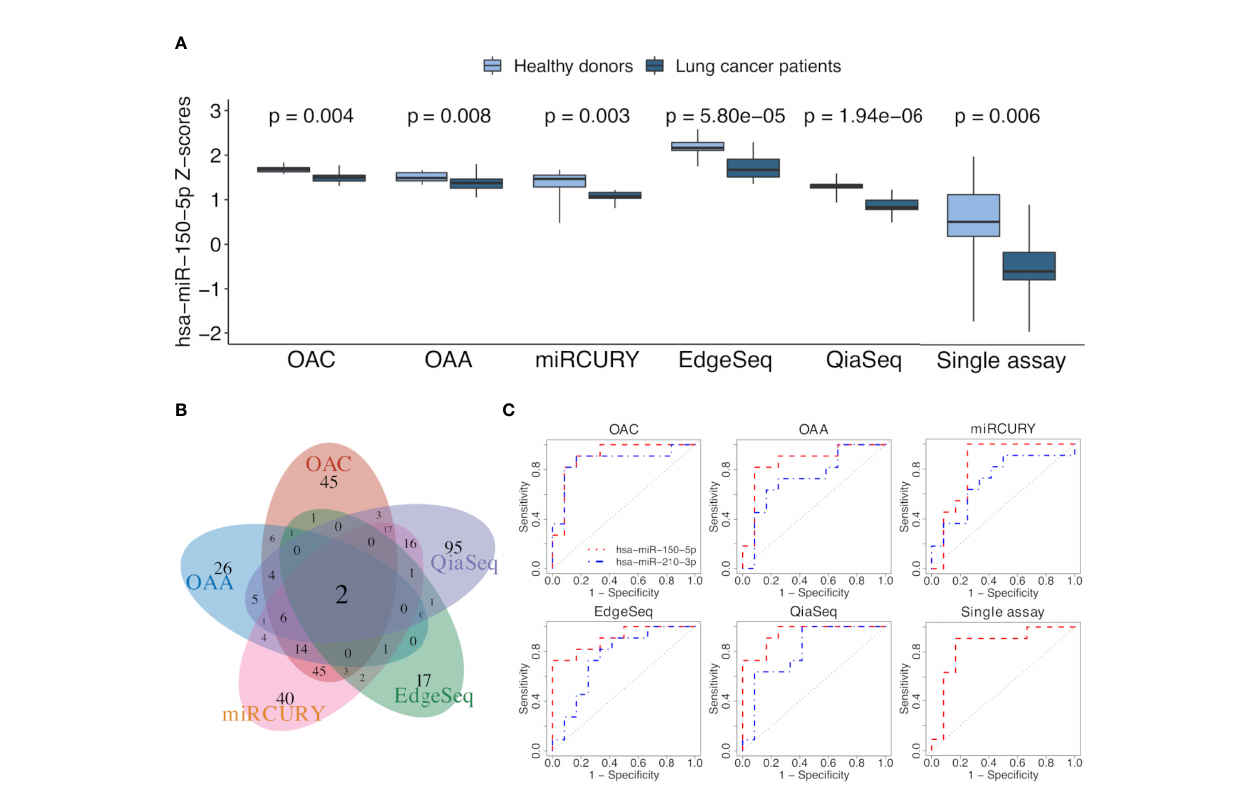
FIGURE 5 | ct-miR differential expression and validation. (A) Boxplots reporting the differences in the expression values of miR-150-5p between non-small cell lung cancer (NSCLC) patients and healthy donors in all platforms. Single-assay validation test of miR-150-5p after normalization to the reference miR-93-5p is reported. All p -values were obtained using limma, except for the single assay where unpaired two-tailed t -test was applied. (B) Venn diagram showing the intersection of AUC values above 0.7, calculated on normalized miR values of all the platforms. (C) Receiver operating characteristic (ROC) curves of miR-150-5p (orange) and miR-210- 3p (blue) obtained by comparing the two groups of lung cancer patients and healthy donors. The area under the ROC curve is above 0.7 for both miRs in all the platforms and even for miR-150-5p in the validation single